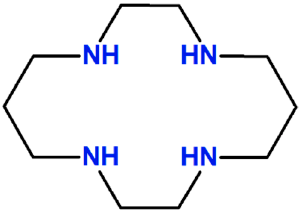
Figure 1. The chemical formula of the cyclam structure.